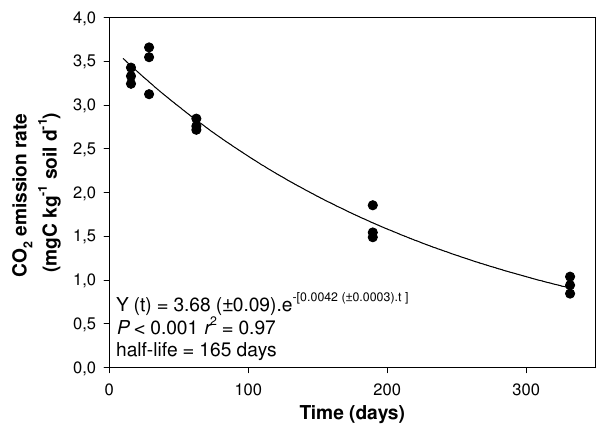
Fig. 5. CO 2 emission rate from the irradiated-soil from Theix incu- bated during 238 days. Half-life ( t 1 / 2 ) was calculated from a simple exponential model.